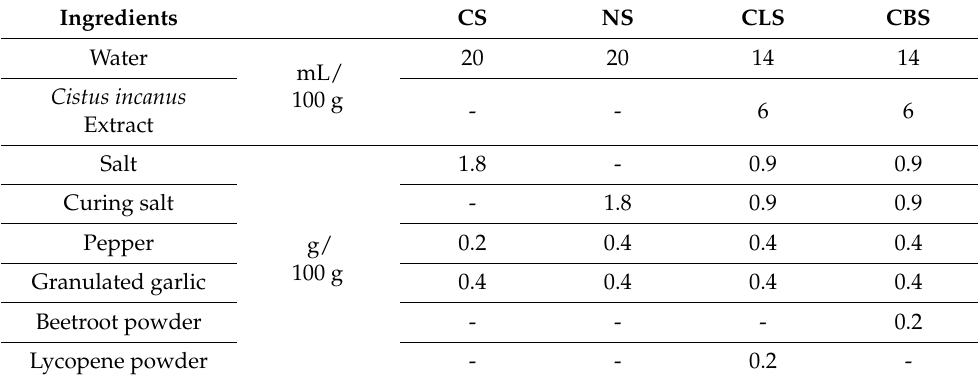
Table 1. Content of additives in the sausage